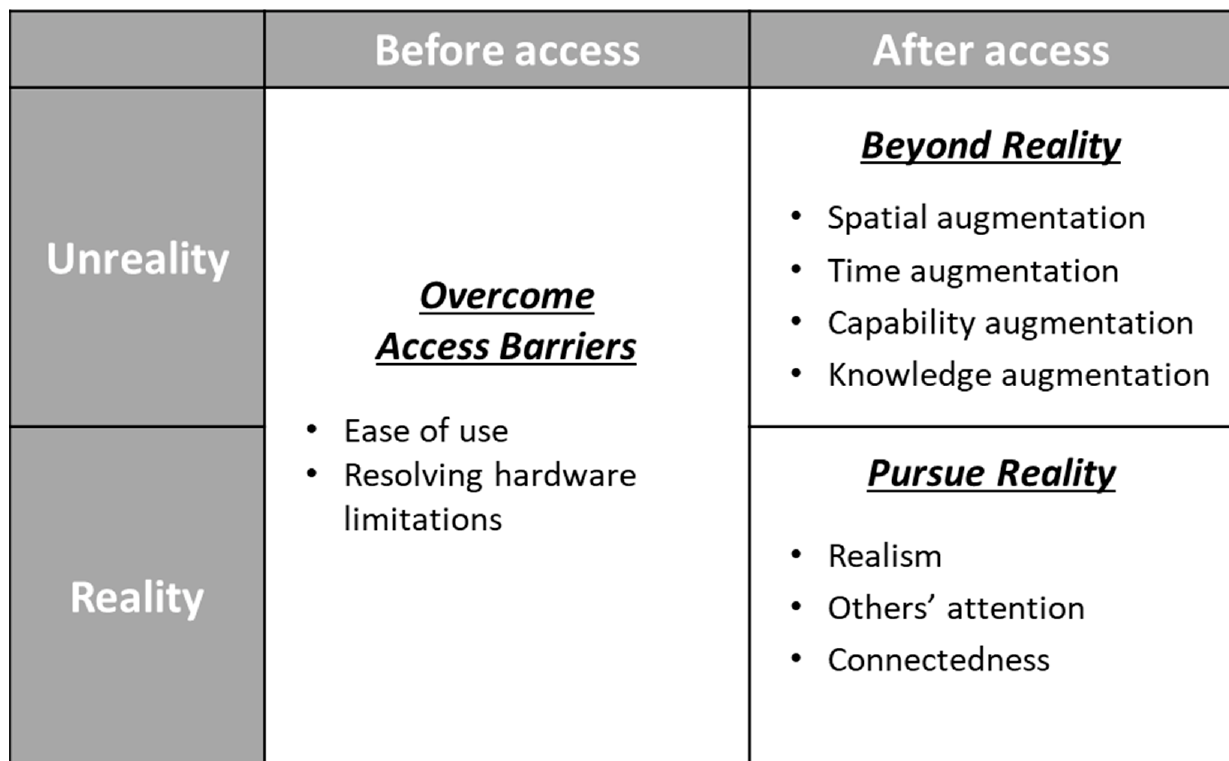
Figure 1. Model of demand for HAT in the COVID-19 pandemic.